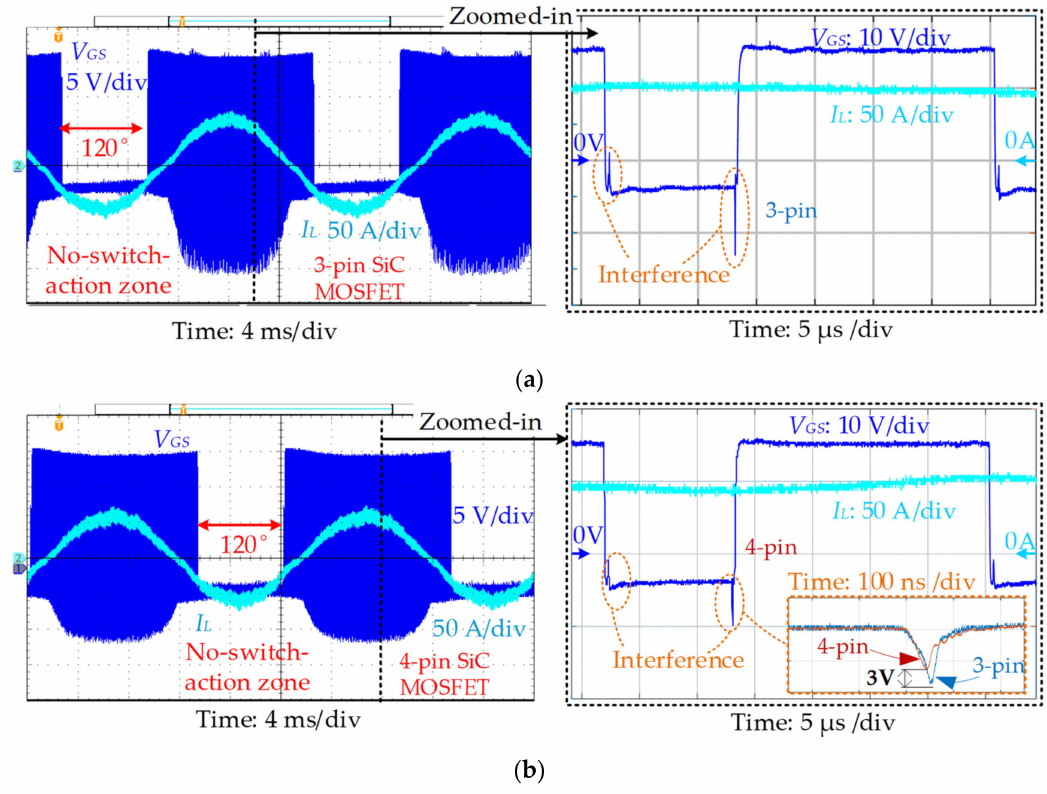
Figure 8. The experiment result of the all-SiC PWM rectifier: ( a ) 3-pin version, ( b ) 4-pin